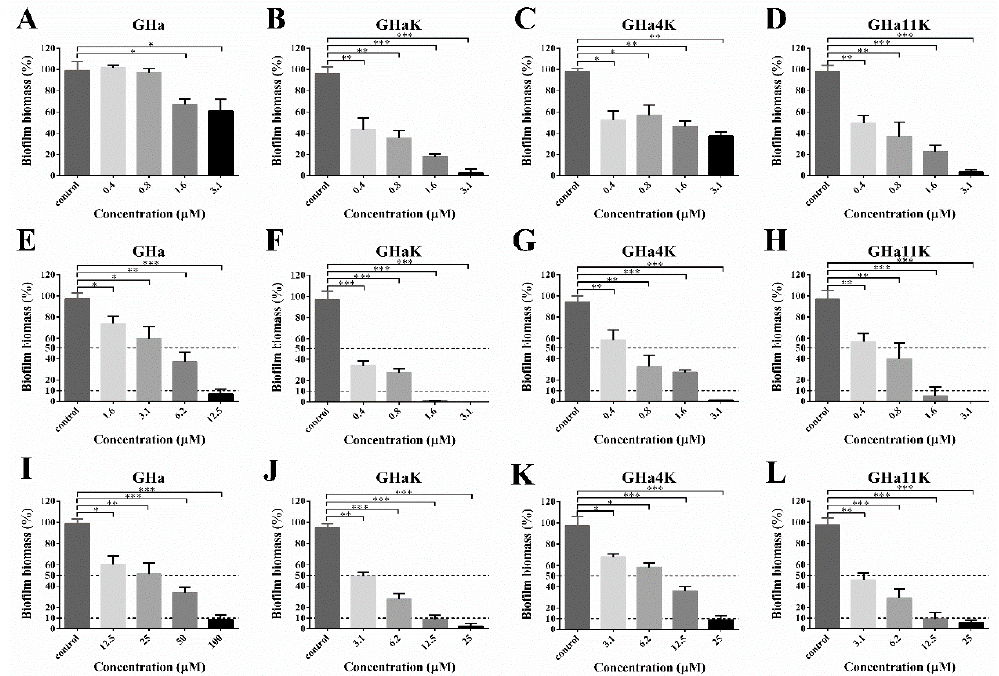
Figure 5. The biofilm attachment inhibitory of the ( A ) GHa, ( B ) GHaK, ( C ) GHa4K, and ( D ) GHa11K, biofilm formation inhibitory of the ( E ) GHa, ( F ) GHaK, ( G ) GHa4K, and ( H ) GHa11K and biofilm eradication of the ( I ) GHa, ( J ) GHaK, ( K ) GHa4K, and ( L ) GHa11K. Dashed lines represent the 10% and 50% of the biofilm biomass (* p < 0.05; ** p < 0.01; *** p < 0.001).